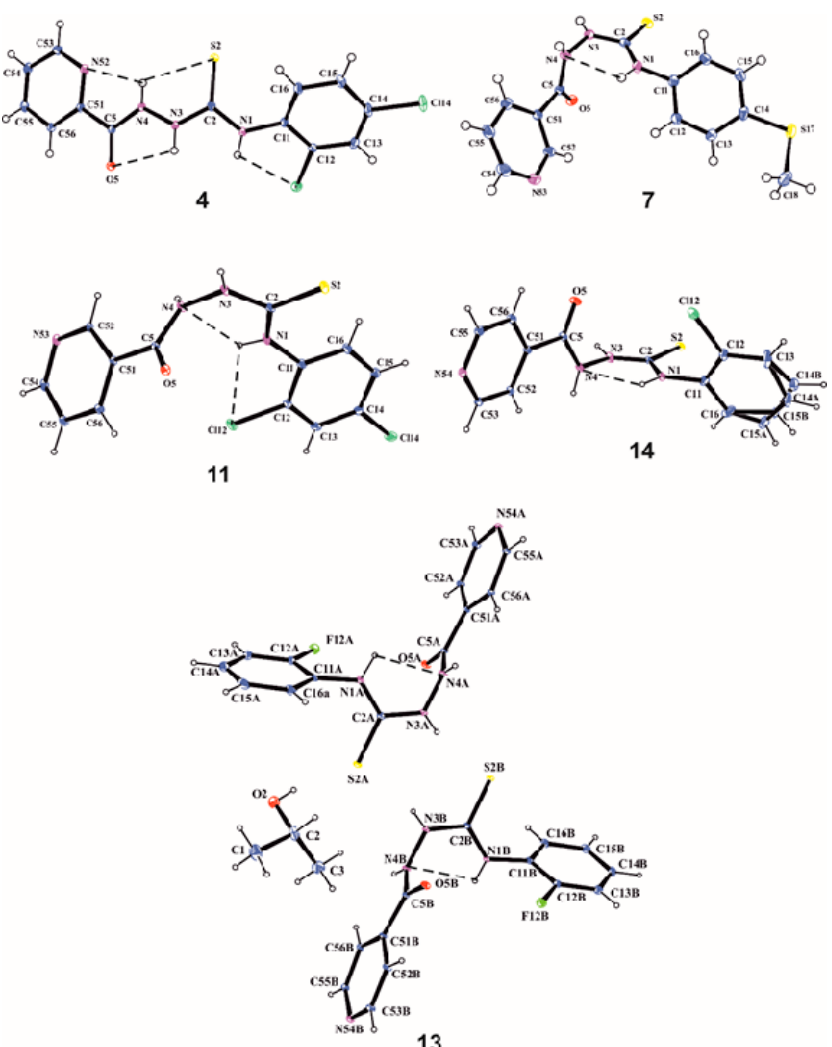
Figure 1. The molecular structures of compounds 4 , 7 , 11 , 13 and 14 with atom labelling and displacement ellipsoids drawing at the 30% probability level.